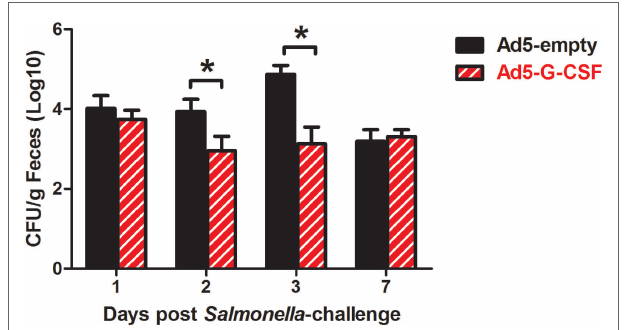
FigUre 2 | Fecal shedding from Salmonella -challenged pigs, with or without prior ad5-g-csF administration . On day 4 following Ad5-G-CSF or Ad5-empty administration, all 16 pigs were challenged with 1 × 10 7 CFU of S . Typhimurium UK1. Salmonella fecal shedding was monitored via bacteriological analysis of fecal samples collected at 1, 2, 3, and 7 d.p.i. *At each timepoint, significant difference ( P < 0.05) in Salmonella CFU/g feces comparing pigs administered Ad5-G-CSF versus Ad5-empty.